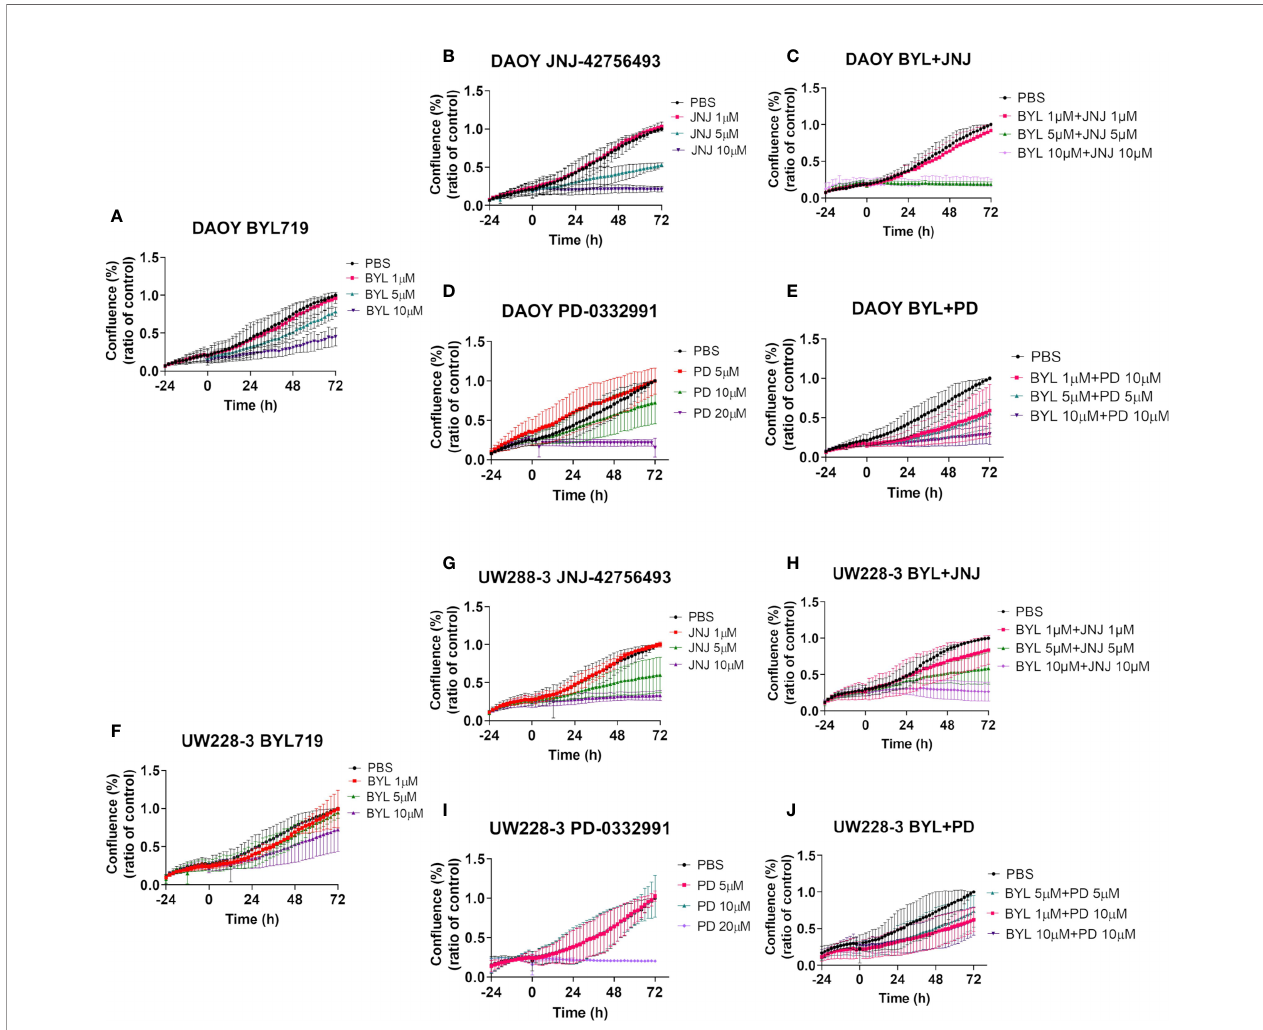
FIGURE 3 | Cell con fl uence after single and combination treatments with BYL719 and JNJ-42756493 and BYL719 and PD-0332991 in MB cell lines DAOY and UW228-3. Single treatments are shown for BYL719 in (A, F) JNJ-42756493 in (B, G) and for PD-332991 in (D, I) for DAOY and UW228-3, respectively. Combination treatments of BYL719 and JNJ-42756493 are shown in (C, H) and of BYL719 and PD-332991 in (E, J) for DAOY and UW228-3, respectively. BYL, BYL719; JNJ, JNJ-42756493; PD,